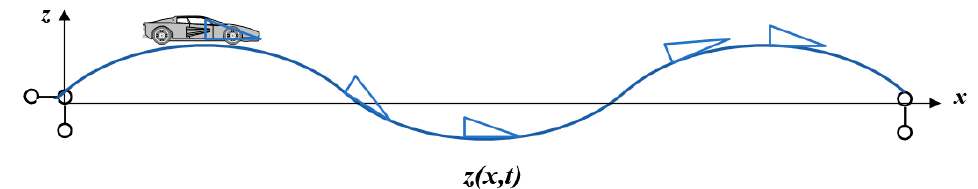
Figure 3. Diagram of the change in the front blind area of the driver’s vision under VVIV (the blue triangle represents simplified vehicle models). triangle represents simplified vehicle models). triangle represents simplified vehicle models).